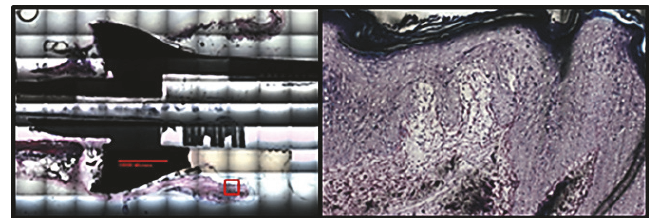
Figure 4: This figure shows the transcutaneous adaption of the skin epithelialization at the implant-skin interface (Sheep 1A).